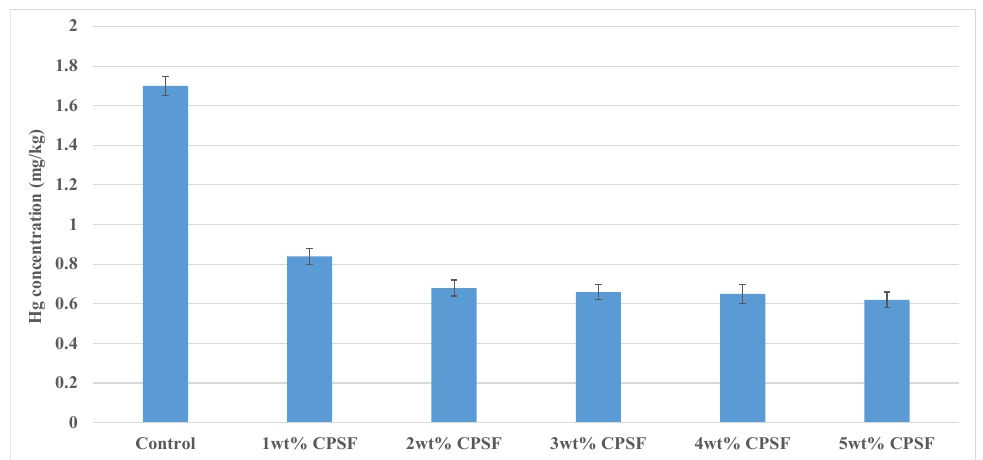
Figure 8. Hg leachability of the control and CPSF (-#10 mesh) treated samples after 28 d of curing, upon 1N HCl extraction.